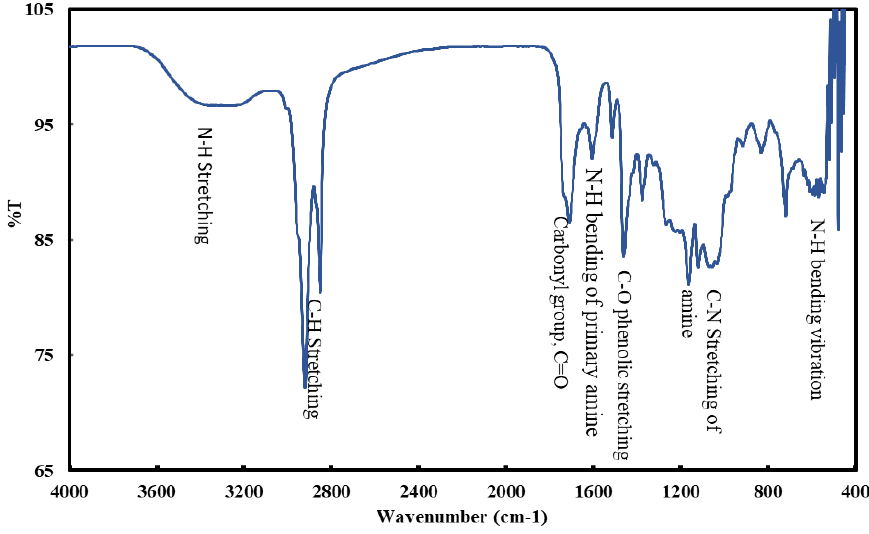
Figure 2. FTIR spectrum of CNSA.